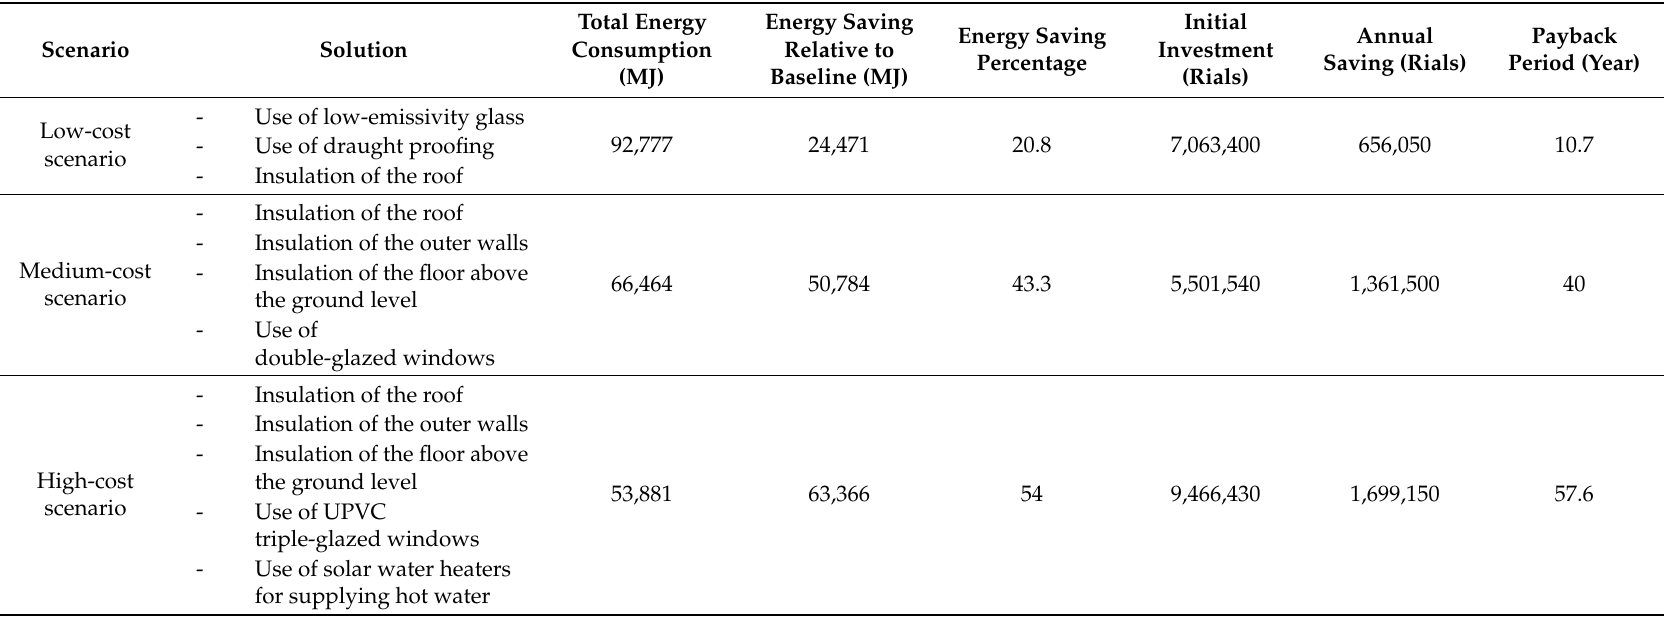
Table 7. Energy consumption at present and in each optimization